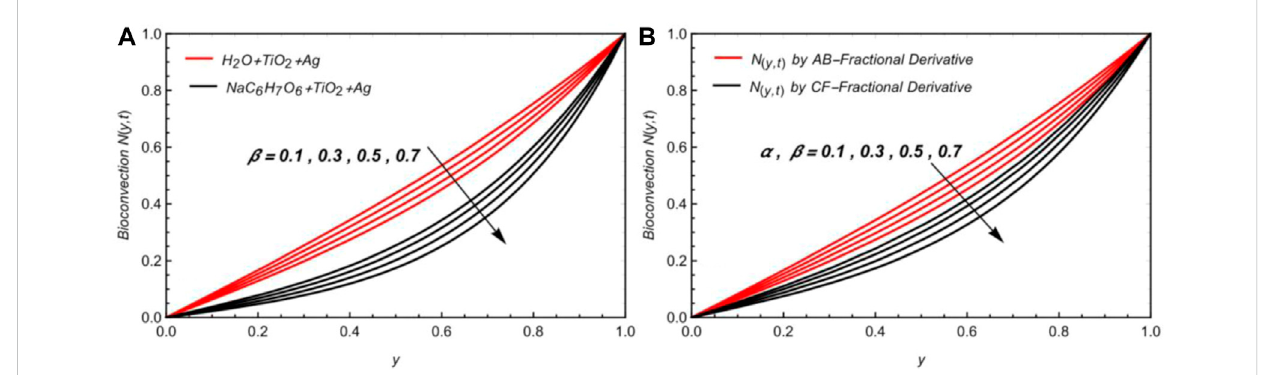
FIGURE 2 N ( y , t ) due to variation in fractional parameters with φ (cid:2) 0 . 02and t (cid:2) 0 . 8.